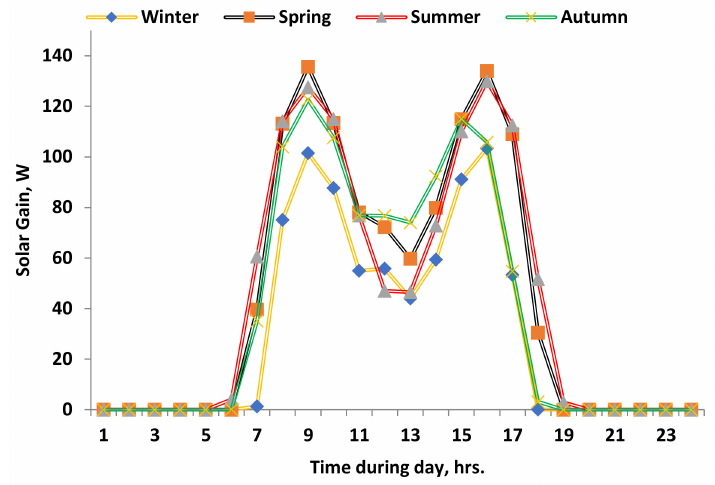
Figure 10. Solar heat gain (SHG) in underground room in all seasons, W. The study revealed that the use of evaporative cooling could reduce indoor tem- peratures during the daytime by 12 ◦ C in summer. This was an enormous reduction, significantly affecting both the comfort level of the users, as well as the energy use (Figure 11). This is quite similar to the work of Rabani [10], which used evaporative cooling and reported a temperature reduction of 7–13 ◦ C. The system also helped to in- crease the relative humidity by 45% to be in the range of 40% to 60%. Such an improvement had a clear effect on the level of thermal comfort of the occupants, and hence, considerably reduced the energy for cooling. The cooling system was found to be very efficient, as shown in Figure 12, which also shows the frequency of decrease in the temperature and increase in the humidity in a 5 min recording slot. During the first hour, the temperature dropped by 7 ◦ C, and the humidity increased by 13%. This was also linked to the high thermal mass construction of the ground of the underground buildings. This had a clear effect on the total amount of building heat transfer that was exchanged with the building zone in both winter and summer, where in winter, it was found to be warmer than the outdoor temperature, and in summer, it was found to be cooler. This point will hopefully stimulate further research.